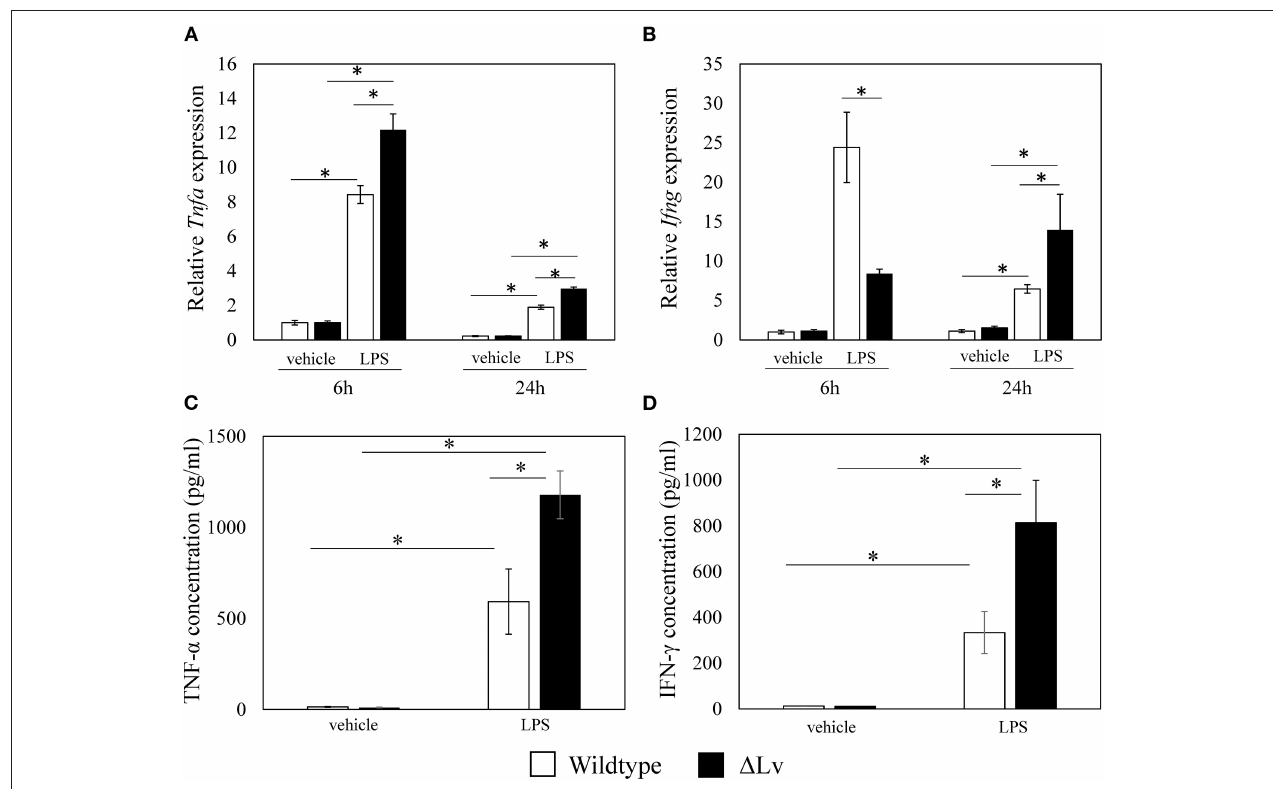
FIGURE 4 | Effect of peptide Lv deficiency on LPS-mediated TNF- α and IFN- γ production. (A) Tnfa and (B) Ifng expression levels in vehicle- and LPS-treated BMM obtained from wild-type and peptide Lv- deficient ( 1 Lv) mice. Relative Tnfa expression was determined based on the expression in vehicle-treated BMM. (C) TNF- α and (D) IFN- γ protein levels in the culture supernatant of vehicle- and LPS-treated BMM obtained from wild-type and 1 Lv mice. Values are mean ± SE ( n = 8). * p < 0.05.